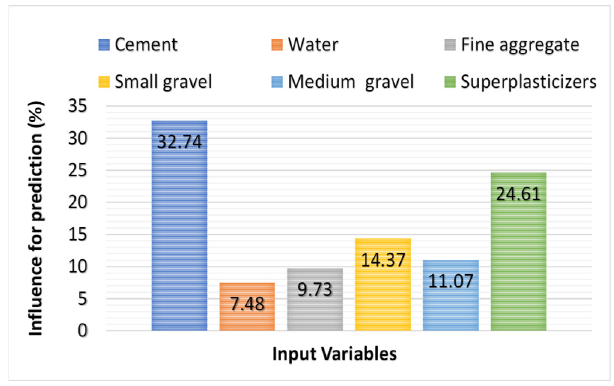
Figure 15. Influence of input parameters on the targeted outcome.